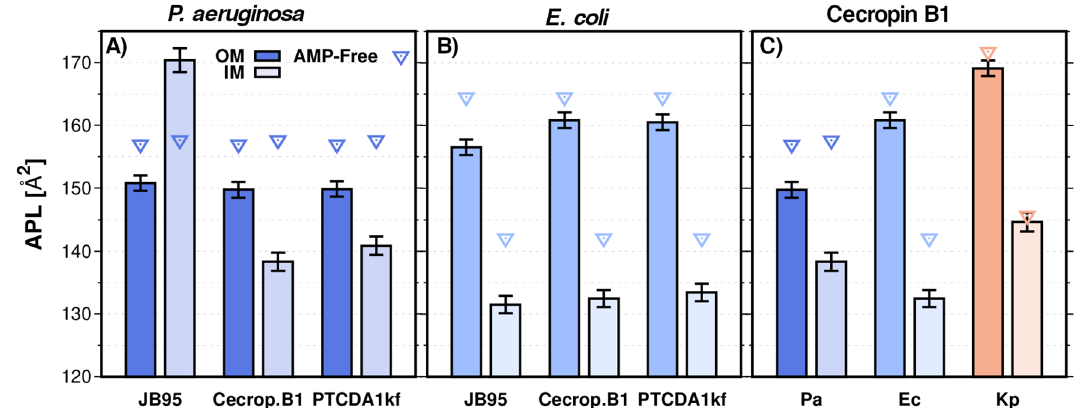
Figure 7. AMP-Dependent APL. ( A – B ) P. aeruginosa and E. coli liposomes. ( C) Cecropin B1 effect on APL of some bacterial liposomes. Filled boxes correspond to OM liposomes and semi-transparent boxes correspond to IM liposomes. Analysis performed on the last μs of the MD